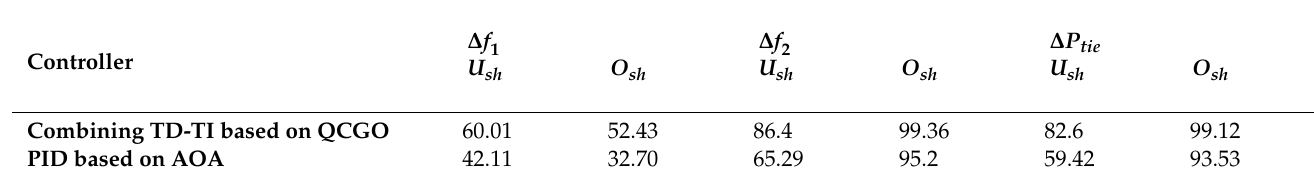
Table 9. Percentage improvement in U sh and O sh values for combining TD-TI/QCGO and PID/AOA based on PID controller via TLBO for scenario